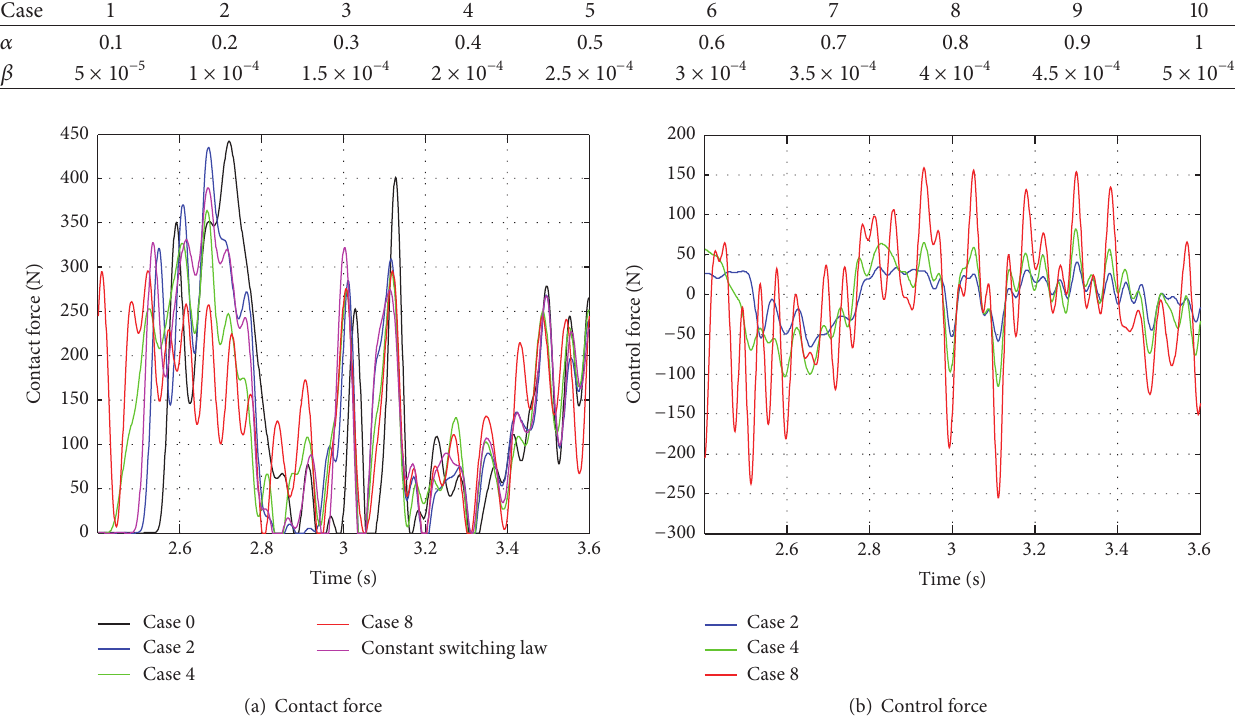
Figure 18: Results of contact force and control force with case 0, case 2, case 4, and case